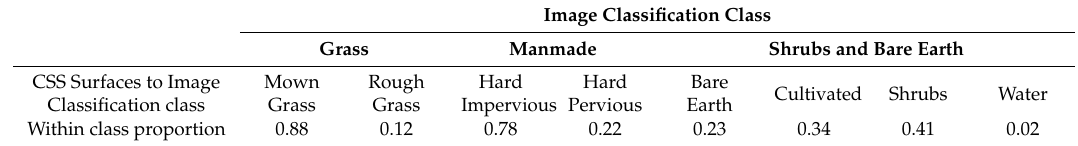
Table 8. Extrapolation multipliers for CSS surfaces calculated as within image classification class proportion.